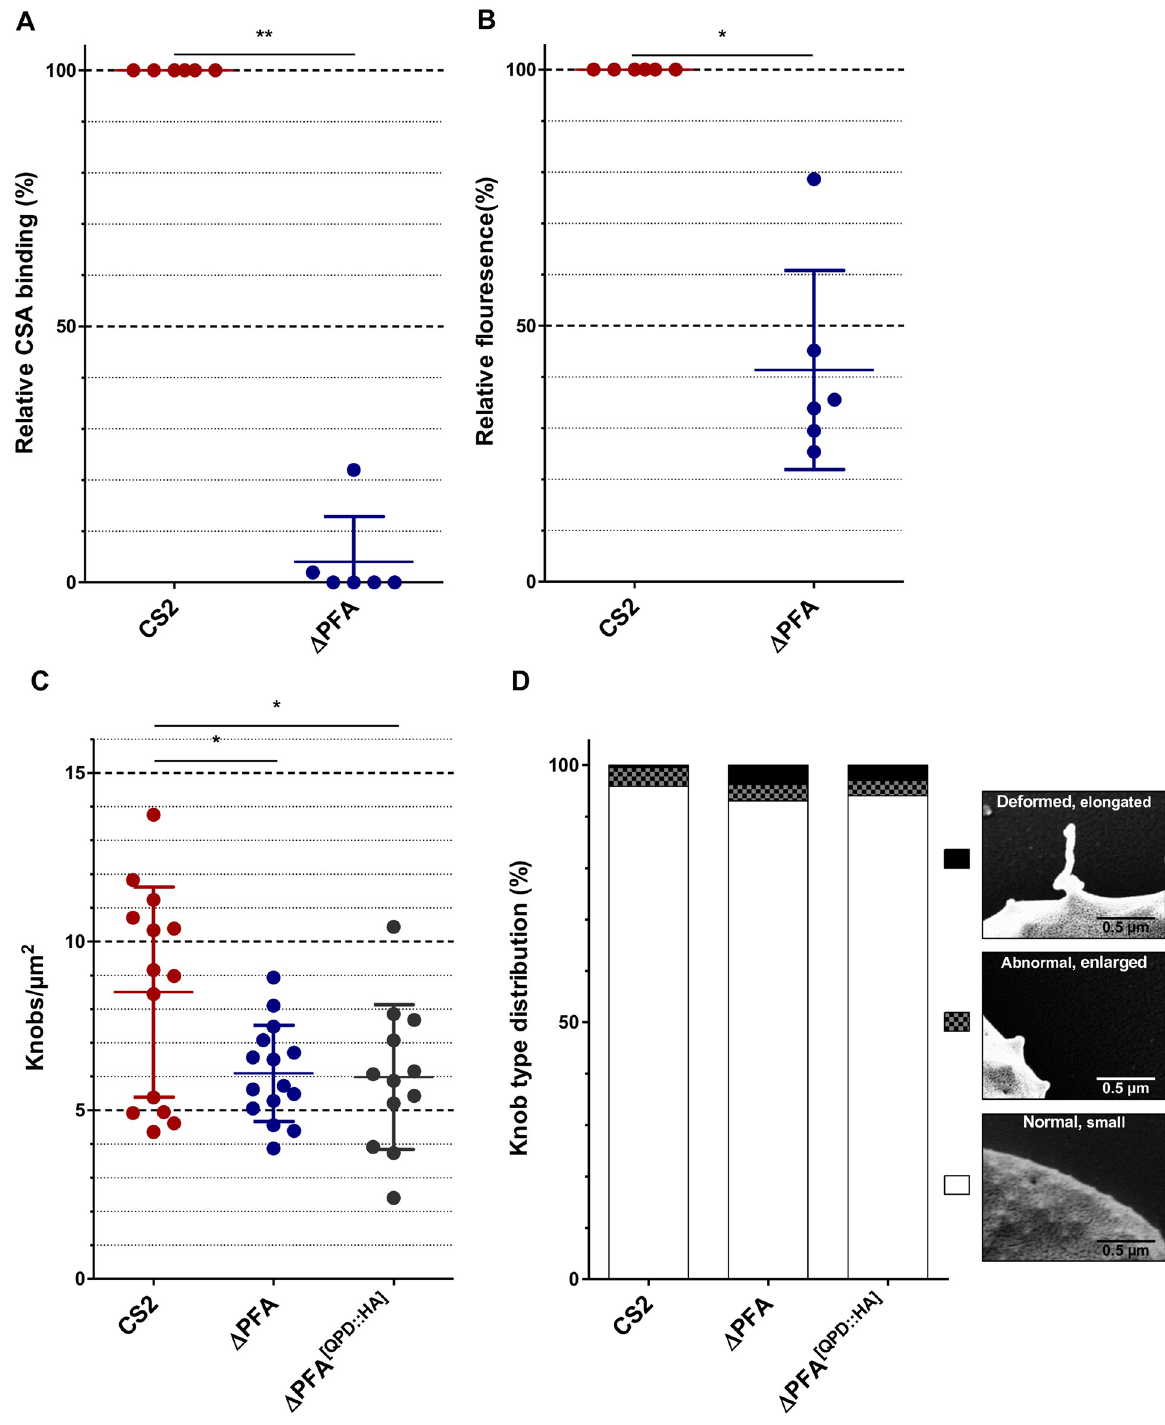
Fig 5. Δ PFA iRBCs display negligible cytoadherence and lower surface exposed PfEMP1. A) Δ PFA displays negligible cytoadherence and lower Pf EMP1 surface exposure than CS2. CS2 and Δ PFA were assayed to test their ability to adhere to immobilised CSA in Petri dishes using microscopic counting of the cells. Cytoadhesion strength is expressed relative to CS2. Results are shown for six binding assays. B) Analysis of Pf EMP1 surface exposure via flow cytometry. IRBCs were stained with DAPI and α VAR2CSA antiserum followed by a Cy3-coupled secondary antibody. Δ PFAs have lower Pf EMP1 surface exposure than CS2 in six independent experiments. C, D) Expression of a PFA variant featuring a mutated HPD motif in the cell line Δ PFA [QPD :: HA] does not complement reduction in knob abundance (C) and knob deformation (D) observed in Δ PFA . IRBC were purified and imaged via SEM. Knobs were then counted and grouped into three